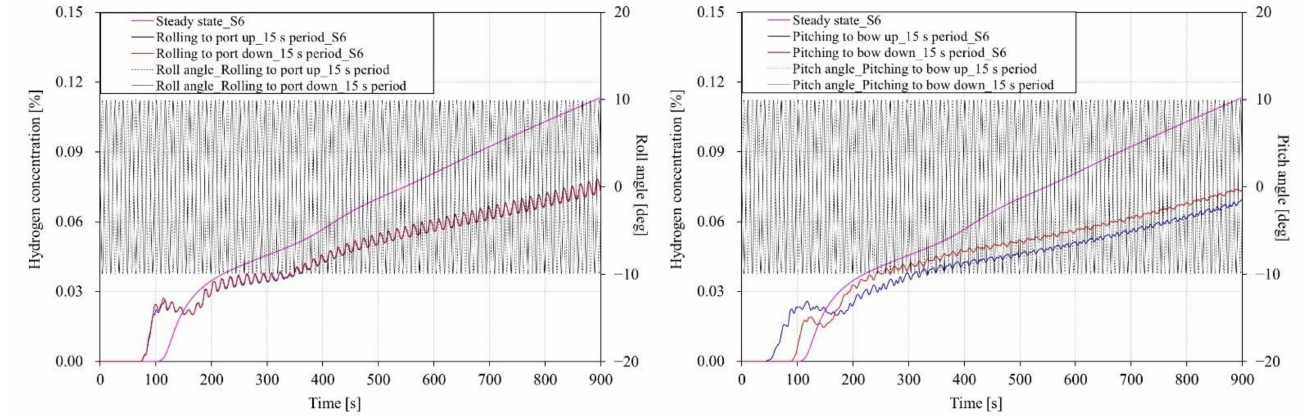
Figure 14. Hydrogen concentration by roll and pitch motion at S6.